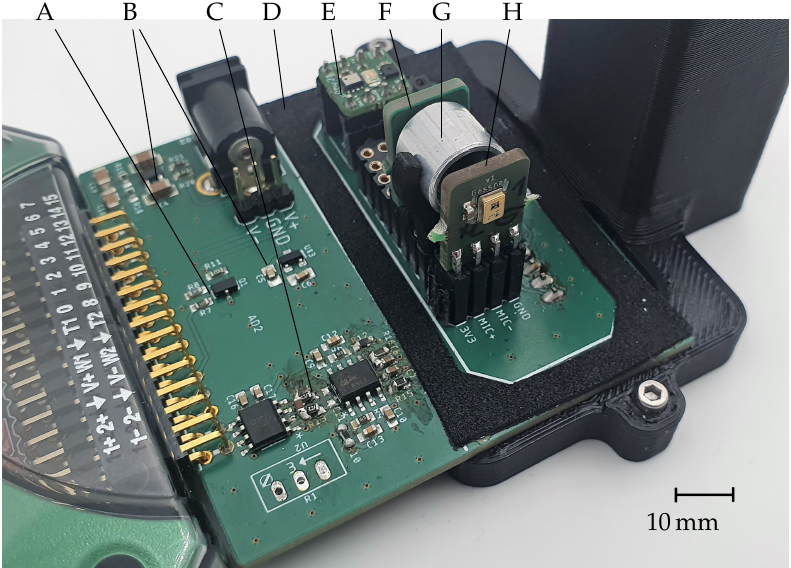
Figure 4. Sensor evaluation PCB with (A) MOSFET (B) power supply (C) amplifier stages (D) gasket (E) reference sensors (F) emitter module (G) reflector tube (H) detector